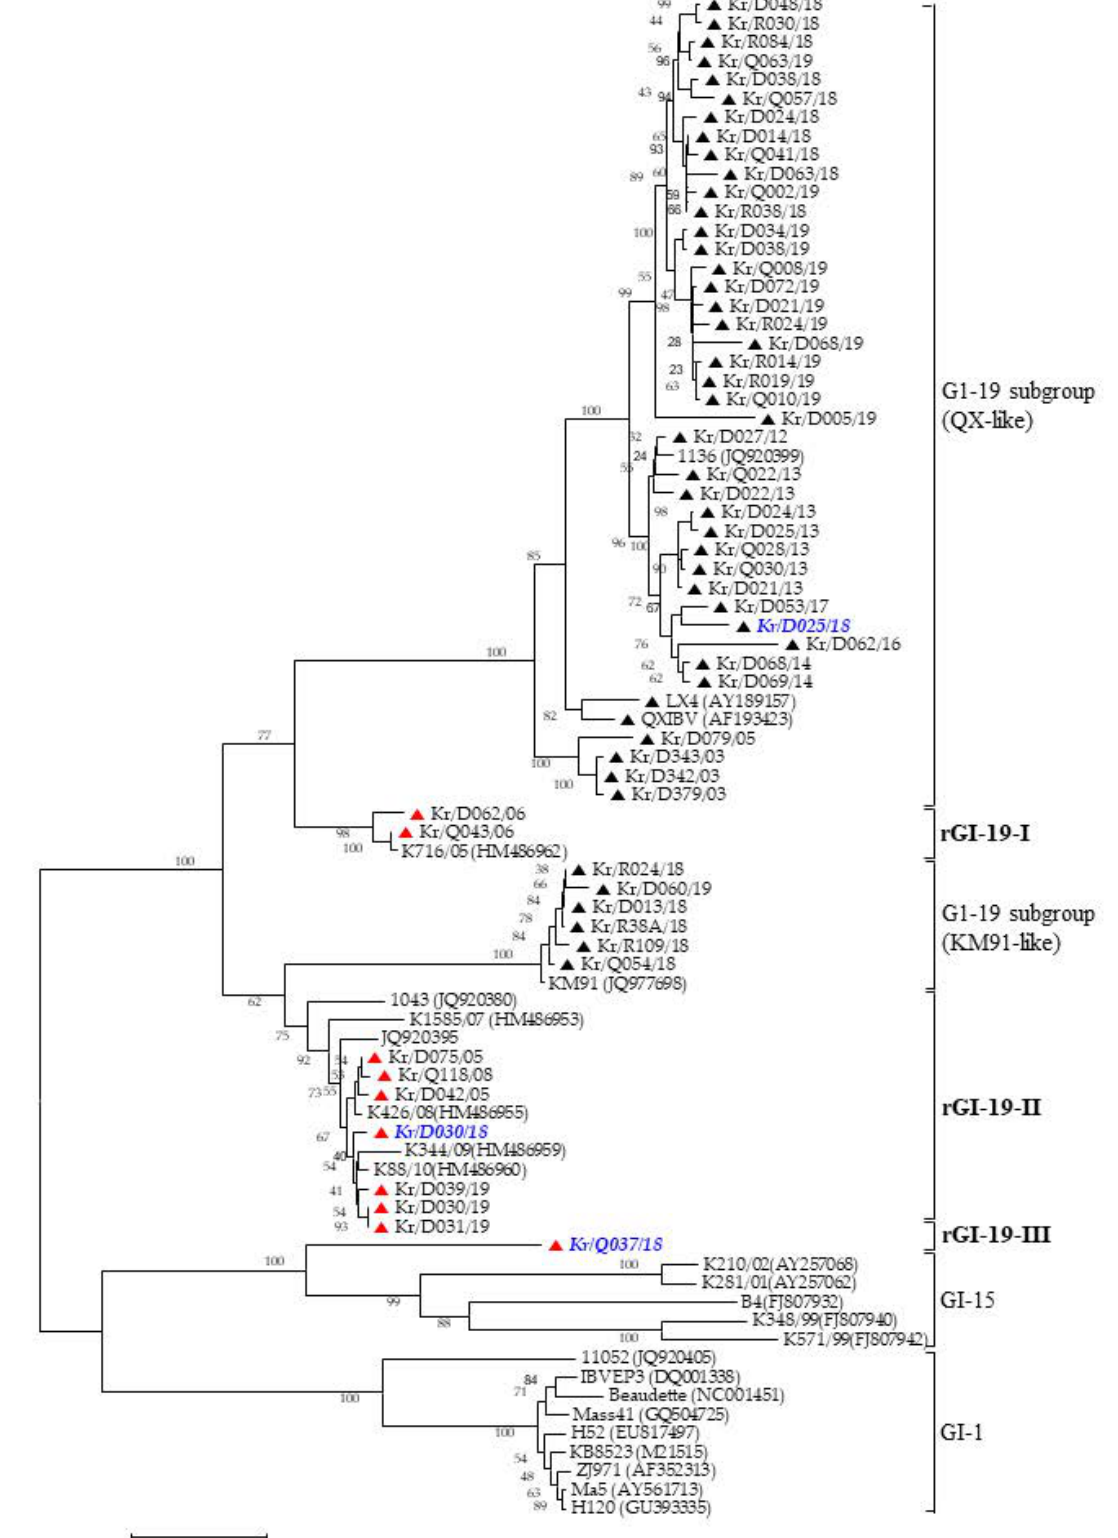
Figure 1. Phylogenetic tree of the S1 nucleotide sequences of 56 IBVs. The recombinant IBVs in this study are marked with a red solid triangle. Other IBVs are marked with a black solid triangle. IBVs are used to pathogenicity test are marked with blue and italics. The provisional designations, including genogroups and sub-genogroups, are indicated on the